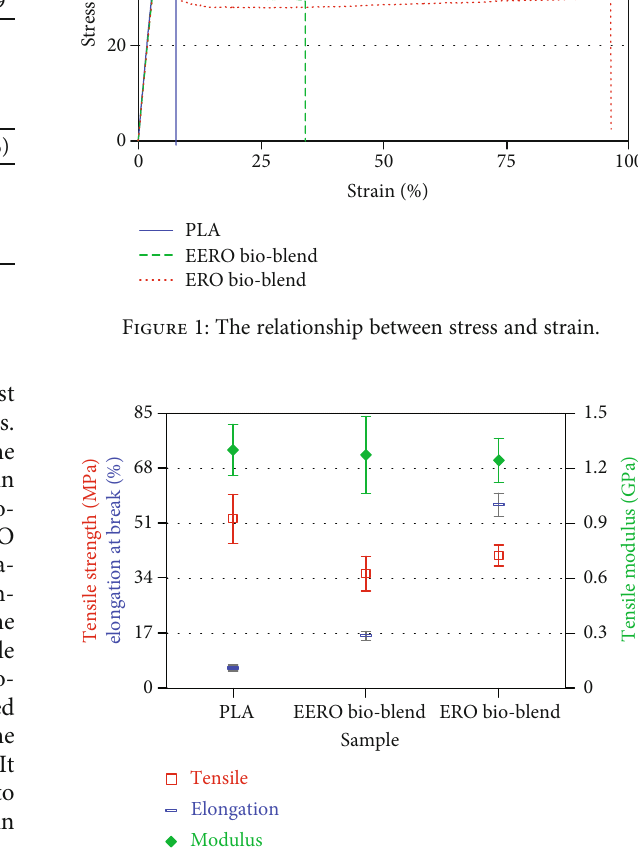
Figure 2: The e ff ect of modi fi ed rubber seed oils on tensile